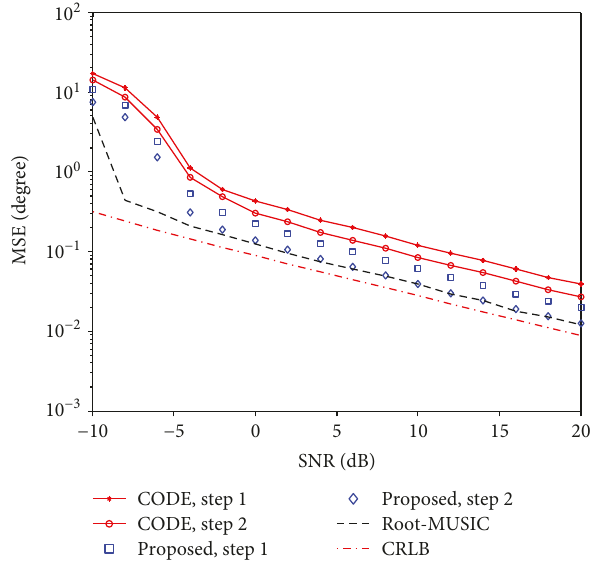
Figure 3: RMSE for θ = 30 ° versus the SNRs, T = 100 , 2 sources at 1 θ = 30 ° and θ = 36 ° , half-wavelength ULA, N = 5 , γ = 0 5 1 2